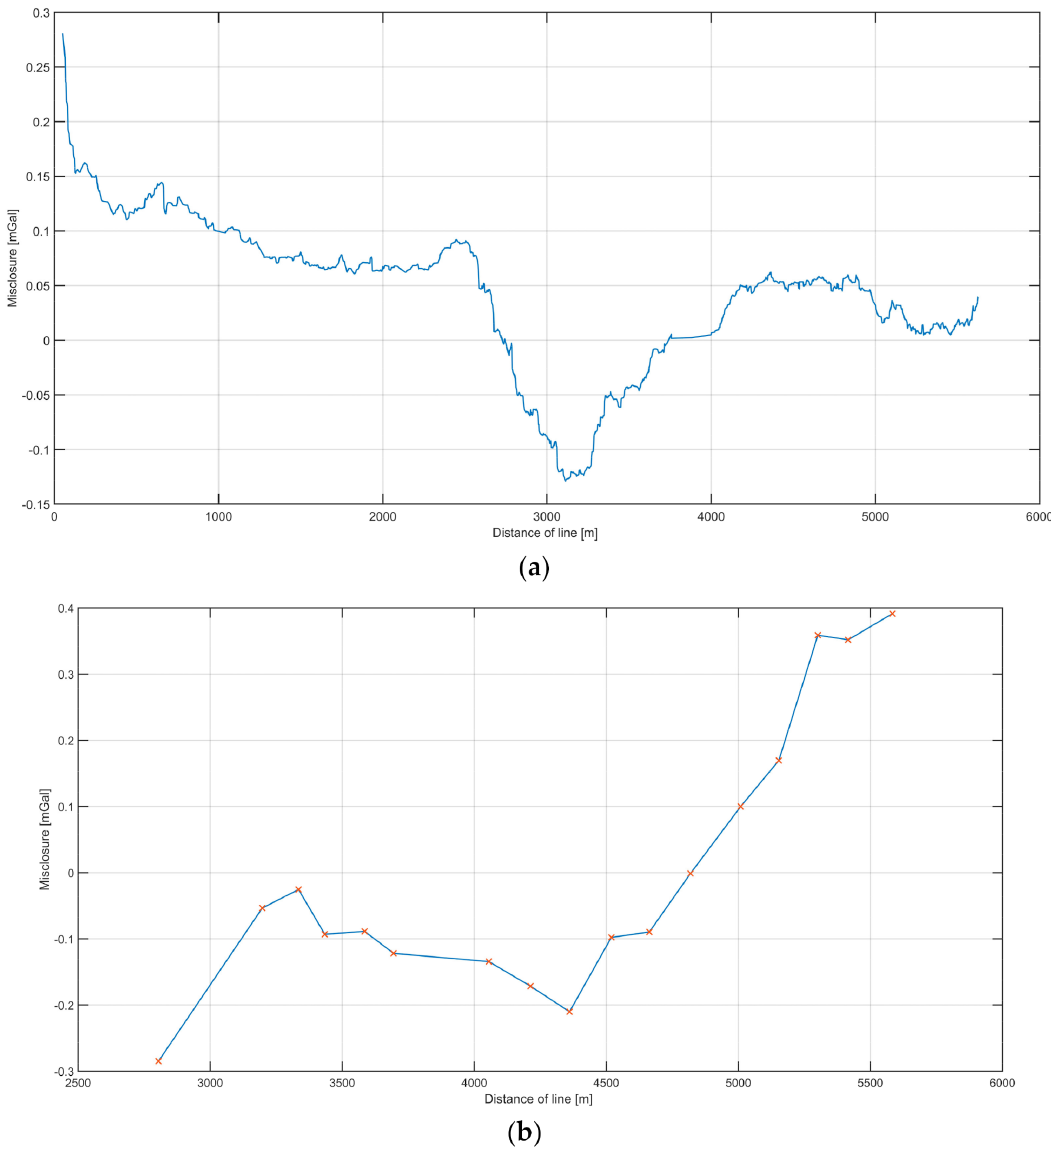
Figure 13. Misclosure analysis of repeated campaign: ( a ) The distribution of di ff erences in the values of gravitational acceleration between the survey lines. ( b ) Distribution of di ff erences between the gravity obtained on land and that measured on a survey line. The height di ff erences have been